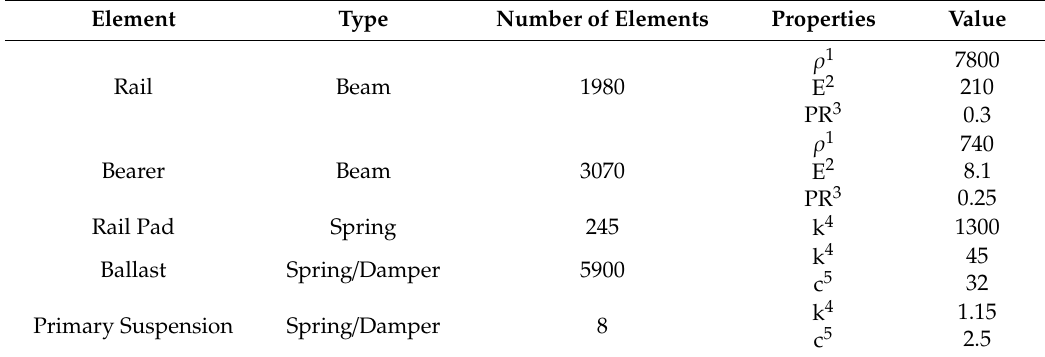
Table 1. Dynamic material properties used in the numerical model